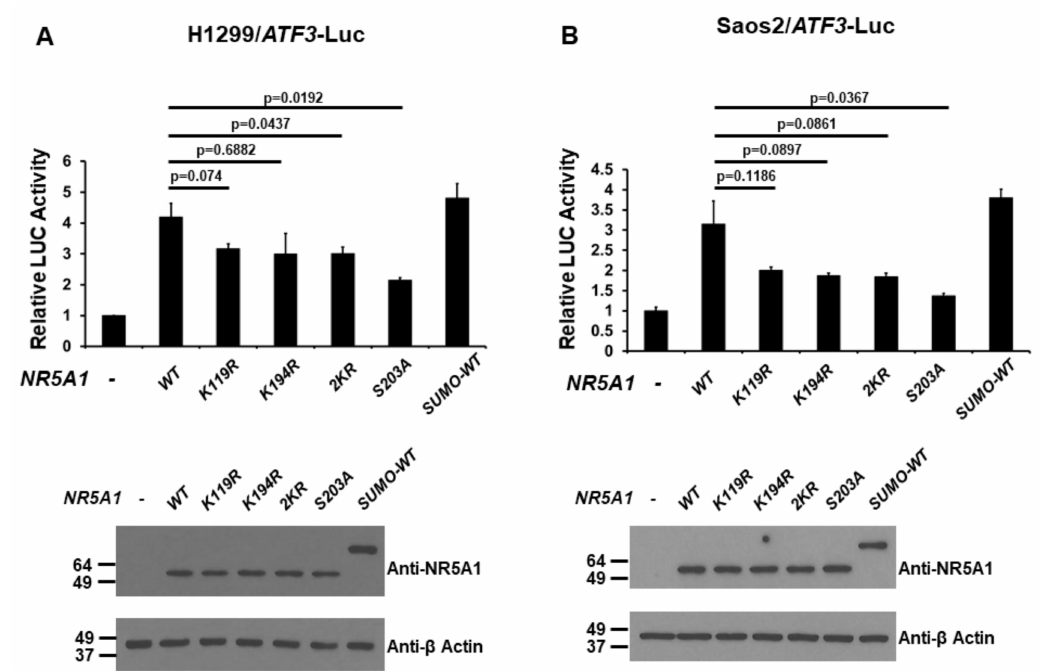
Figure 5. Post-translational modifications of NR5A1 regulate the activation of the ATF3 promoter. ( A ) H1299 and ( B ) Saos2 cells were co-transfected with the ATF3 promoter-LUC reporter plasmid and either wild-type (WT), K119R, K194R, 2KR, S203A, or small ubiquitin-related modifier (SUMO)-WT NR5A1 expression plasmid. Luciferase activities were measured 48 h after transfection and normalized with Renilla activity. Relative LUC activity was calculated and